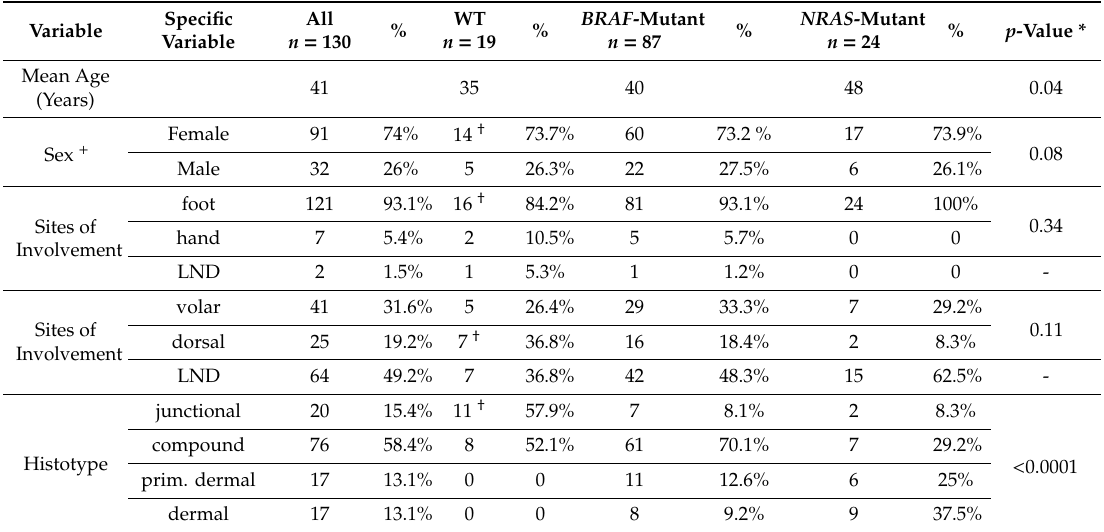
Table 1. Associations of BRAF and NRAS mutation status with clinical and pathological parameters.